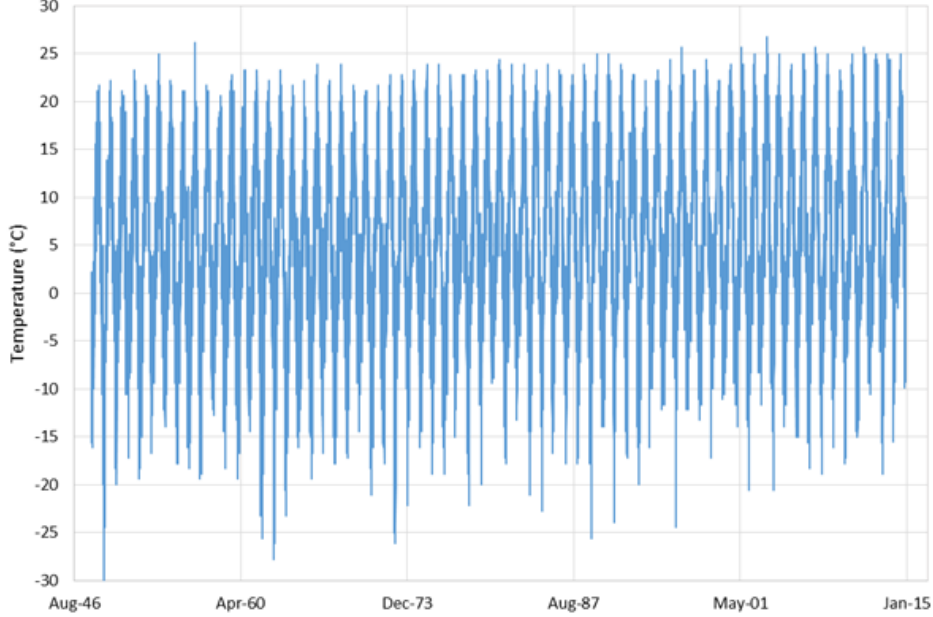
Figure 2. Seventy years of continuous data, (i.e., no missing values or gaps) from the Salt Lake City International Airport (SLIA) station. The figure shows that annual high temperatures are in a relatively narrow range, but annual low temperatures have more variance. We created gaps at random locations and different lengths, imputed data for those gaps, and compared the imputed data to the original, observed data.